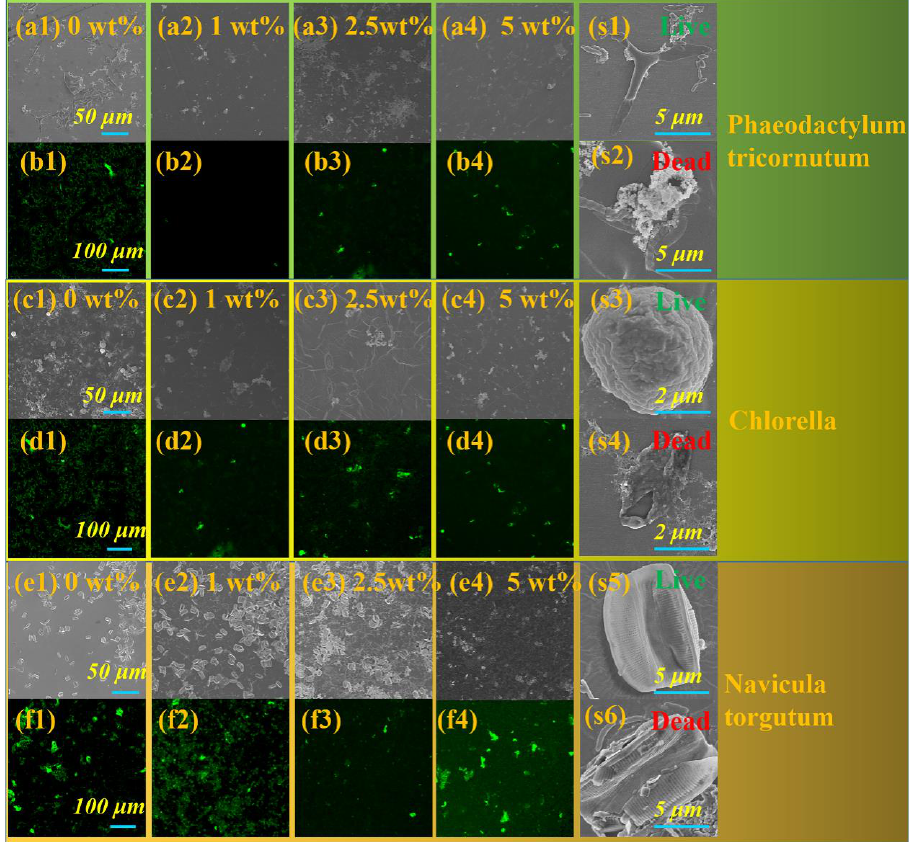
Figure 5. The SEM morphology (( a1 ): 0 wt%, ( a2 ): 1 wt%, ( a3 ): 2.5 wt%, ( a4 ): 5 wt%, ( s1 , 2 )) and fluorescence image (( b1 ): 0 wt%, ( b2 ): 1 wt%, ( b3 ): 2.5 wt%, ( b4 ): 5 wt%) of Phaeodactylum tricornutum after touching ZIF-L/epoxy composites with different contents of ZIF-L; The SEM morphology (( c1 ): 0 wt%, ( c2 ): 1 wt%, ( c3 ): 2.5 wt%, ( c4 ): 5 wt%, ( s3 , 4 )) and fluorescence image (( d1 ): 0 wt%, ( d2 ): 1 wt%, ( d3 ): 2.5 wt%, ( d4 : 5 wt%)) of Chlorella after touching ZIF-L/epoxy composites with different contents of ZIF-L; The SEM morphology (( e1 ): 0 wt%, ( e2 ): 1 wt%, ( e3 ): 2.5 wt%, ( e4 ): 5 wt%, ( s5 , 6 )) and fluorescence image (( f1 ): 0 wt%, ( f2 ): 1 wt%, ( f3 ): 2.5 wt%, ( f4 ): 5 wt%) of Navicula torgutum after touching ZIF-L/epoxy composites with different contents of